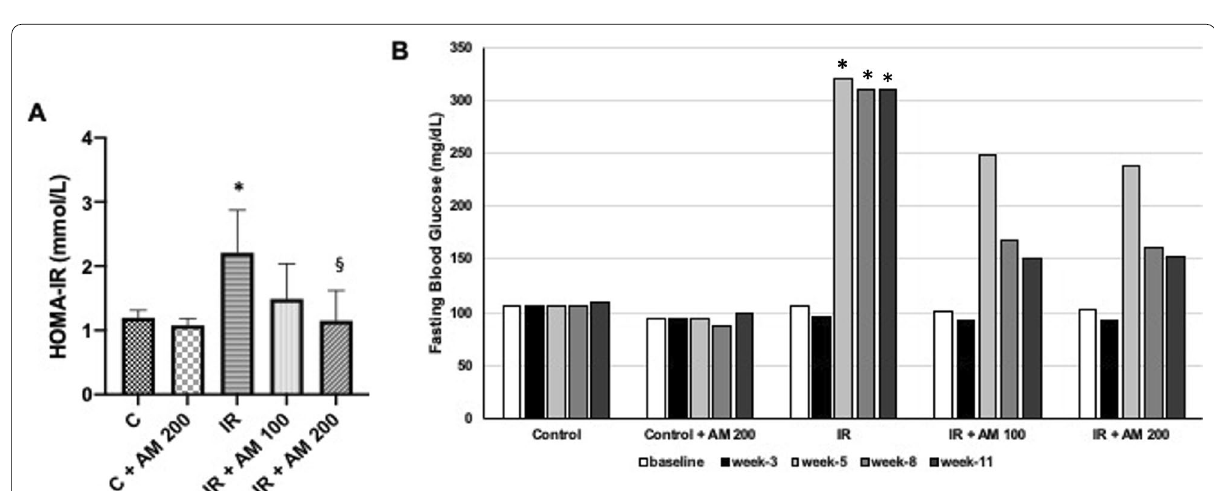
Fig. 1 Effect of AM on A HOMA-IR and B Fasting blood glucose. All values are expressed as the mean 200; $ p < 0.05 versus